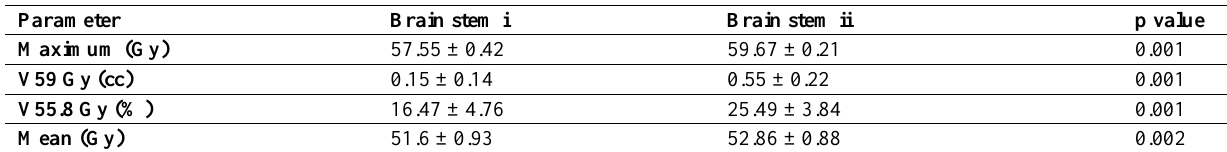
Table 3: Comparison of mean of doses calculated at brain stem i and brain stem ii in combined VMAT-CyberKnife sum plan